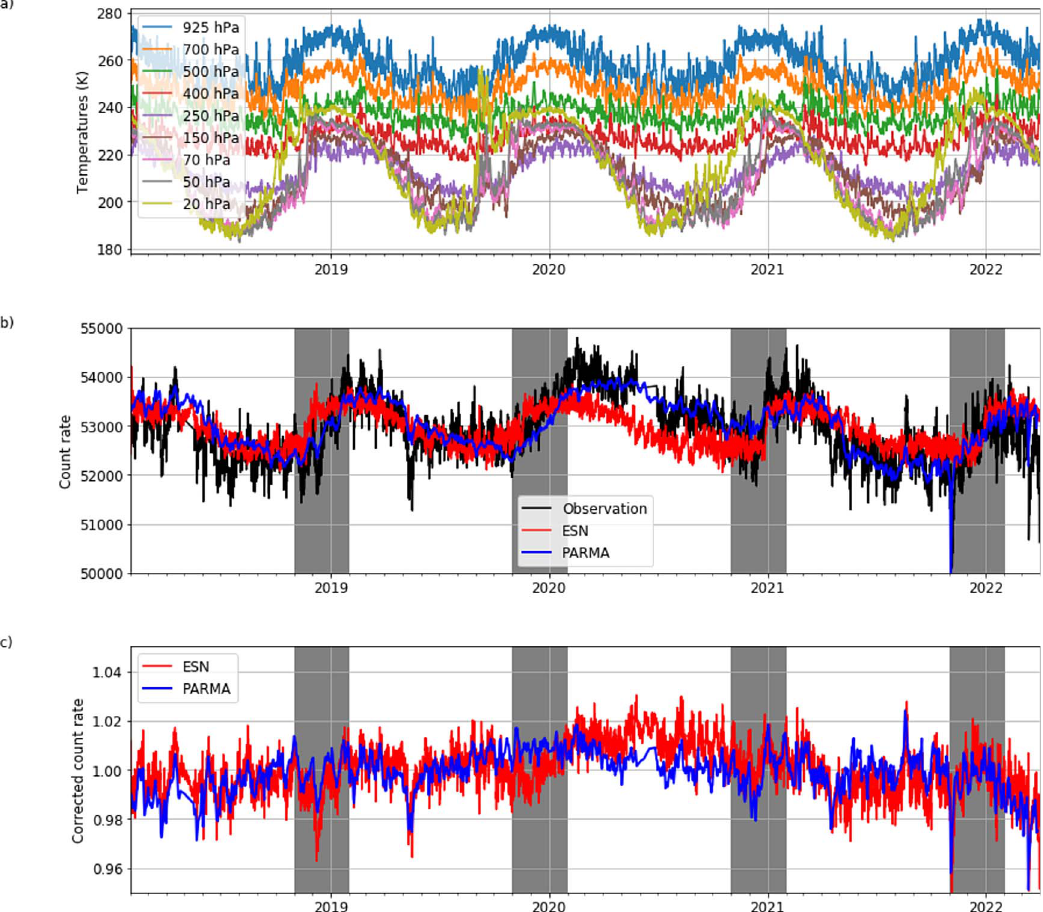
Figure 4. Data-model comparison at Syowa Station. (a) Temperatures at 925, 700, 500, 400, 250, 150, 70, 50, and 20 hPa, identical to Figure 3a, (b) neutron count rate in the unit of counts/min, (c) corrected count